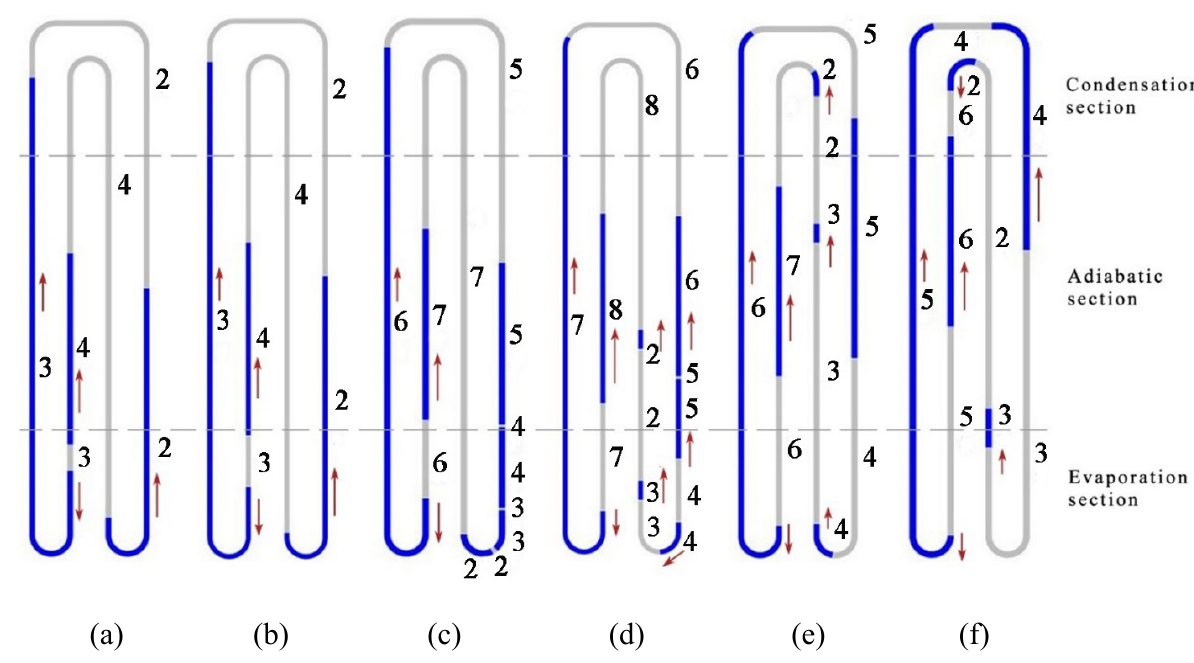
Figure 6. The flow of the liquid slugs at the heat input of 20 W with the time interval of 0.05 s (adiabatic section length = 180 mm): ( a ) 78.45 s, ( b ) 78.50 s, ( c ) 78.55 s, ( d ) 78.60 s, ( e ) 78.65 s, ( f ) 78.70 s.